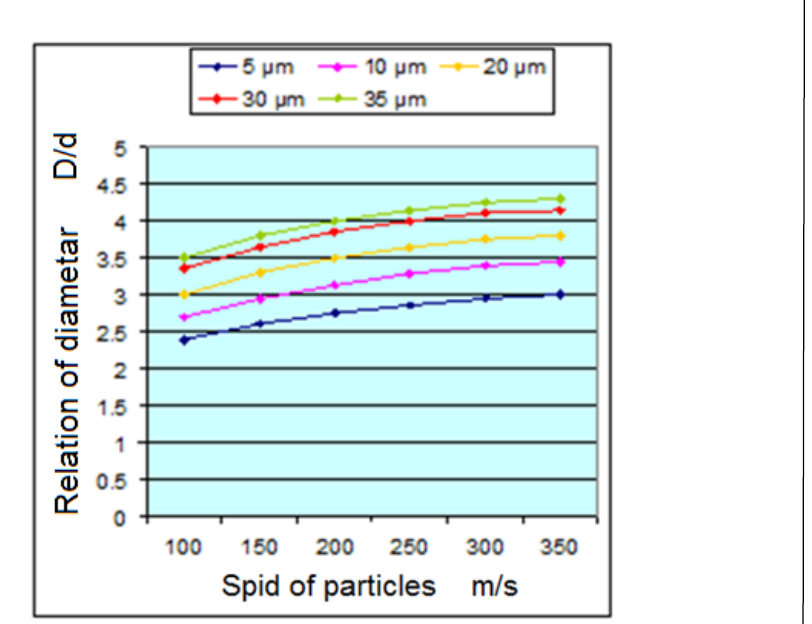
Figure 1 – The D/d ratio depending on the velocity of Al 2 O 3 particles Рис . 1 – Соотношение диаметра D/d в зависимости от скорости частиц Al 2 O 3 Слика 1 – Однос пречника D/d у зависности од брзине честица Al 2 O